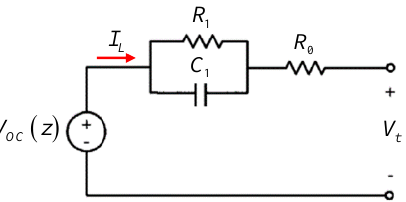
Figure 1. Thevenin’s equivalent circuit model with a single RC